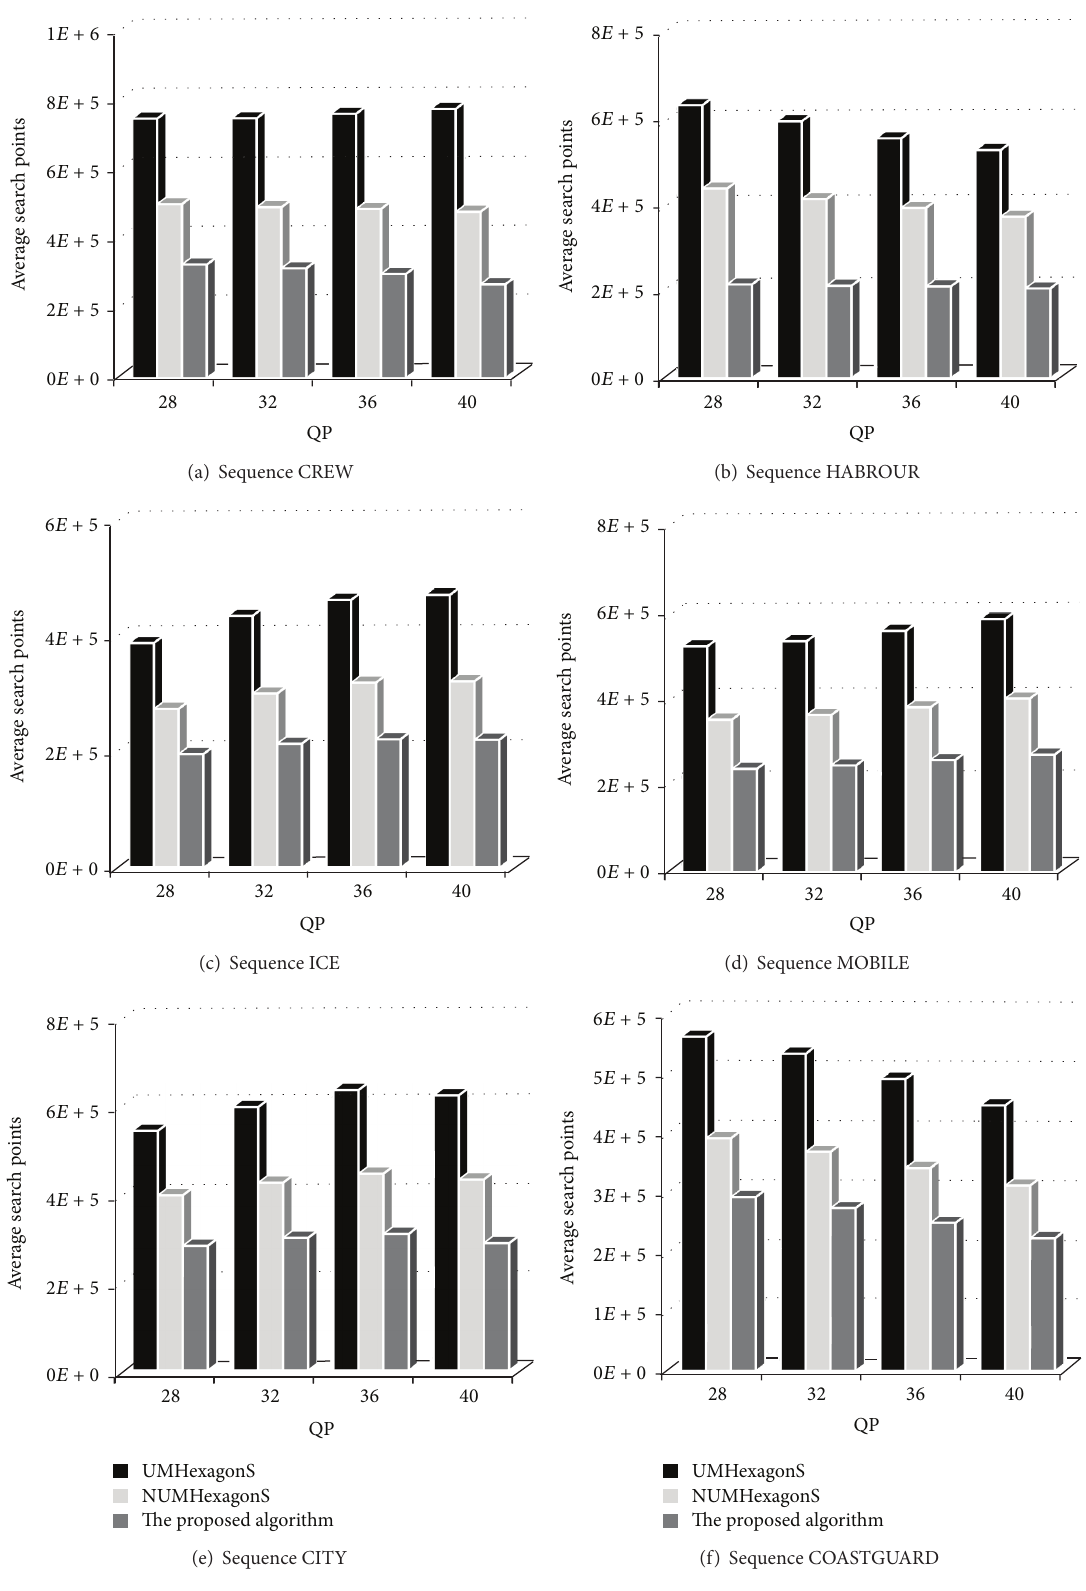
Figure 14: Comparison of average ME search points between UMHexagonS, NUMHexagonS, and the proposed